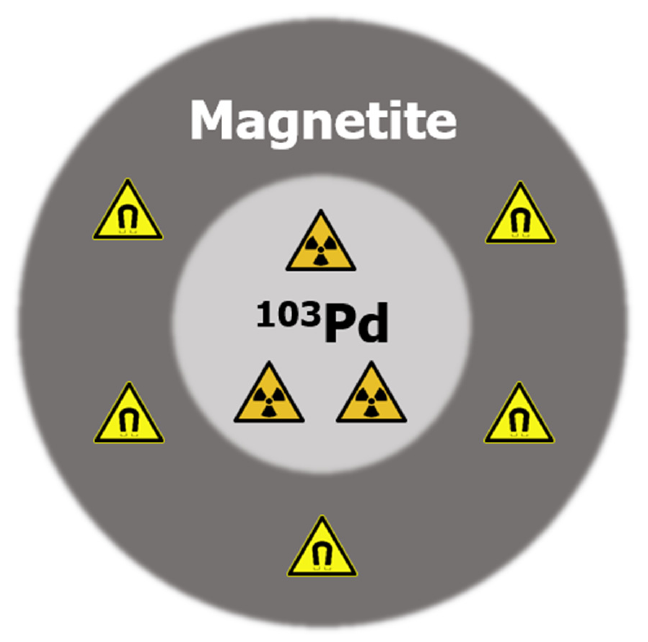
Figure 1. Schematic drawing of the radioactive magnetic nanoparticle, with a core of radioactive 103 Pd and a shell of magnetic iron oxide.